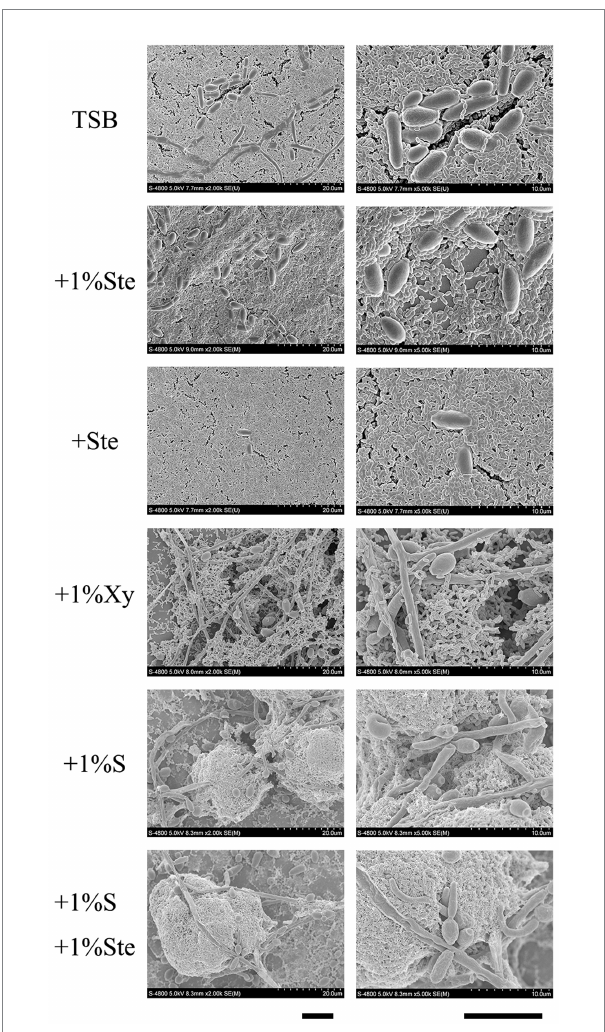
FIGURE 3 Morphological characteristics effects of stevioside on dual-species biofilm of S. mutans and C. albicans by SEM images. Representative SEM images of dual-species biofilm generated by S. mutans and C. albicans treated with different medium after 24 h of biofilm formation. Scale bar: 100 μ